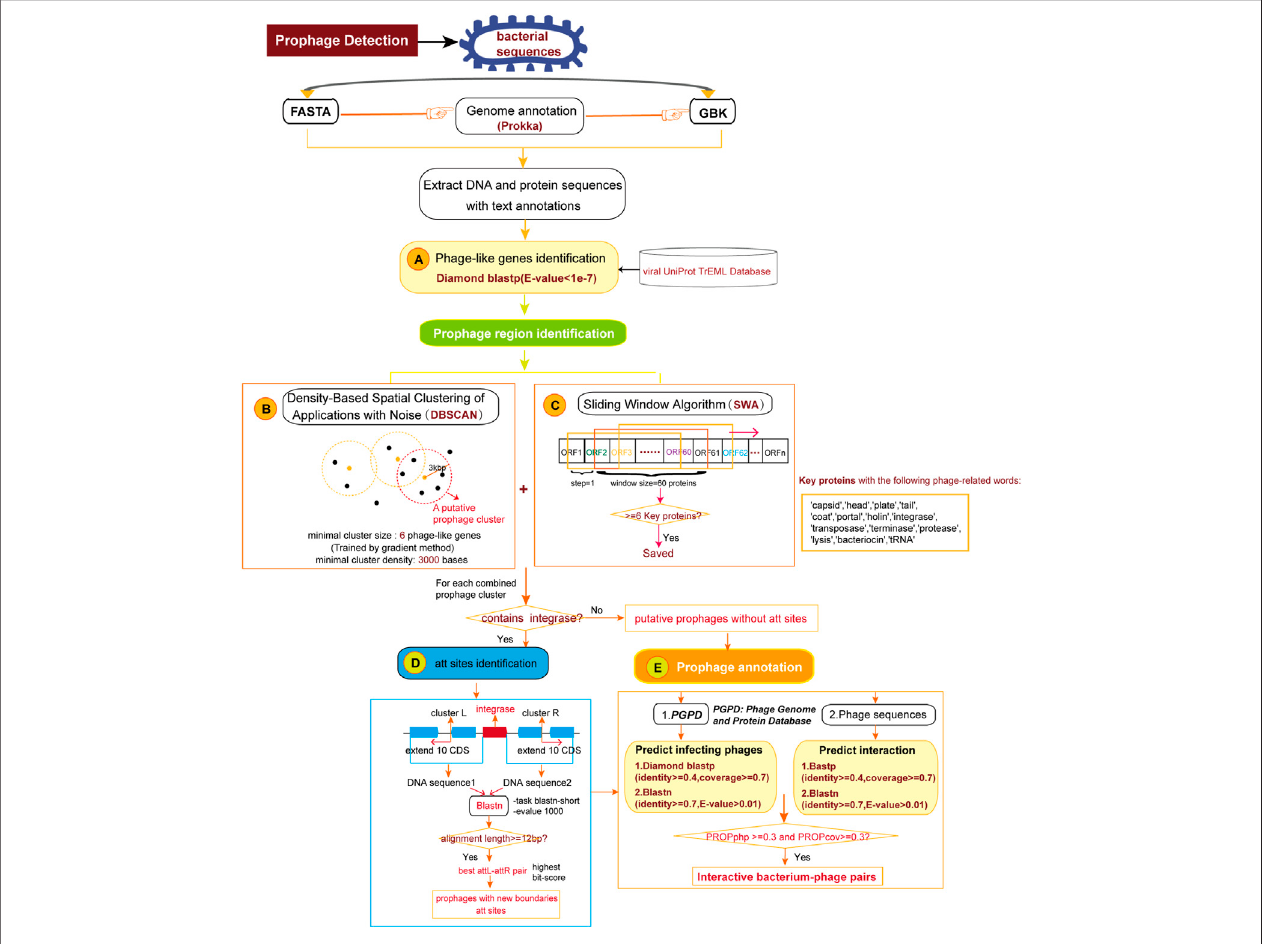
FIGURE 1 | The pipeline for detection and annotation of prophages for bacterial genomes. (A) Identi fi cation of phage or phage-like proteins. (B) Detection of prophage clusters by Density-Based Spatial Clustering of Application with Noise algorithm. (C) Detection of prophage clusters by Sliding Window Algorithm. (D) Identi fi cation of attachment sites in prophage clusters. (E) Annotation of infecting phages for the predicted prophage